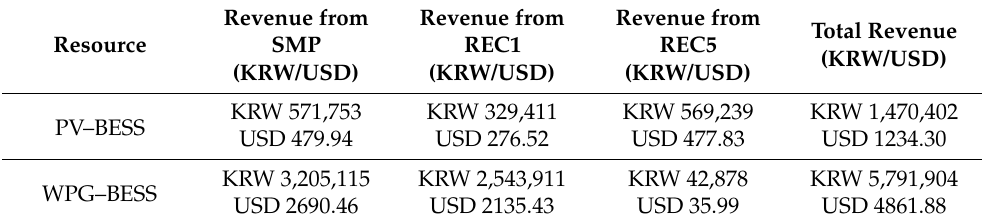
Figure 13. Operation between the BESS and the PV in coordination with profit maximization, with reliability constraints, with incentives: ( a ) intraday operation of the BESS with WPG with the reliability constraint; ( b ) intraday operation of the BESS with the PV with the reliability constraint; ( c ) intraday operation with the reliability constraint and the incentives, for the BESS with WPG; ( d ) intraday operation with the reliability constraint and the incentives, for the BESS with the PV. Table 13. Intraday revenue generated with the reliability constraints without incentives.